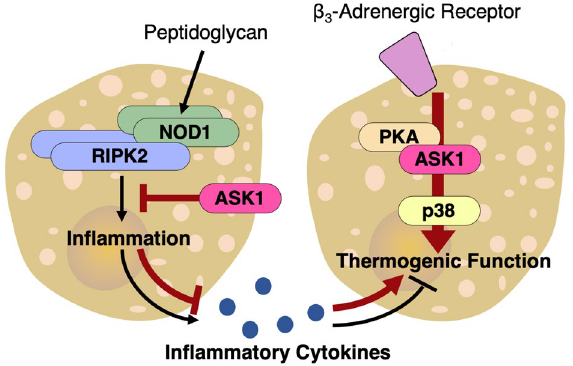
Figure 4. Hypothetical model. Through interacting with RIPK2, ASK1 negatively regulates the NOD-RIPK2 pathway and inflammatory cytokine production in brown adipocytes. Along with the maturation-enhancing effect of ASK1 via the PKA-ASK1-p38 axis under β 3 -adrenergic receptor stimulation 19 , this regulation would contribute to maintaining brown adipocyte function under